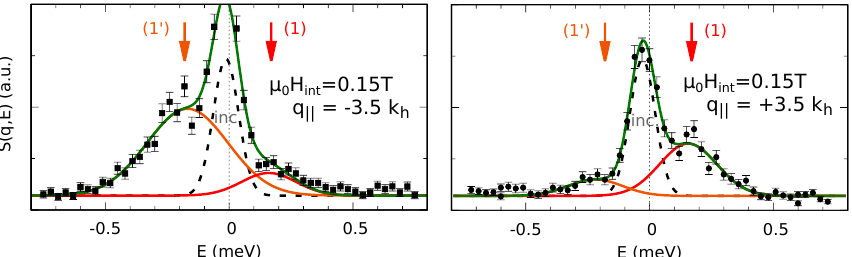
Figure 4. The figure (reproduced from [33], c (cid:13) by the American Institute of Physics, USA) shows the non-reciprocal nature of the skyrmion dynamics for momentum transfers along the skyrmion axis. The lines are Gaussian